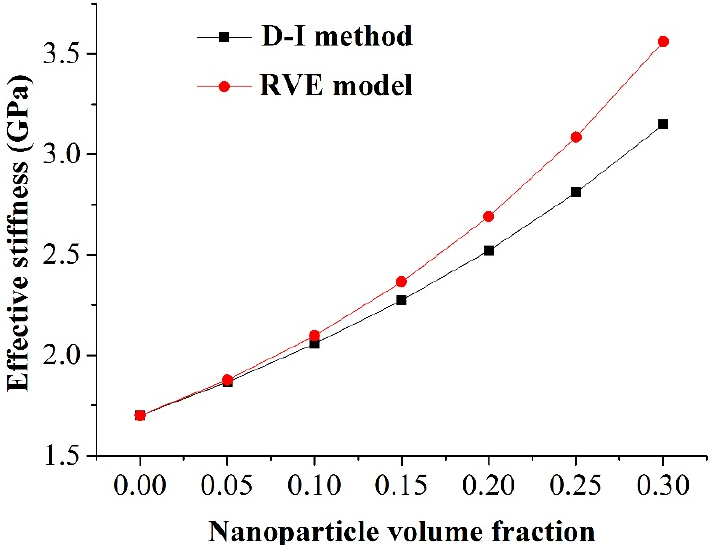
Figure 2. Comparison of the effective stiffness obtained by the representative volume element model and the double-inclusion